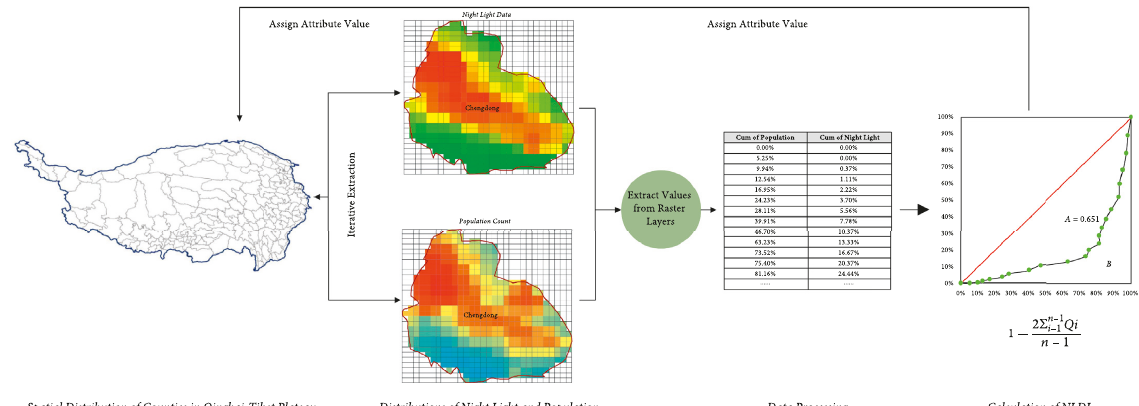
Figure 6: Detail calculation process of nighttime light development index ( NLDI